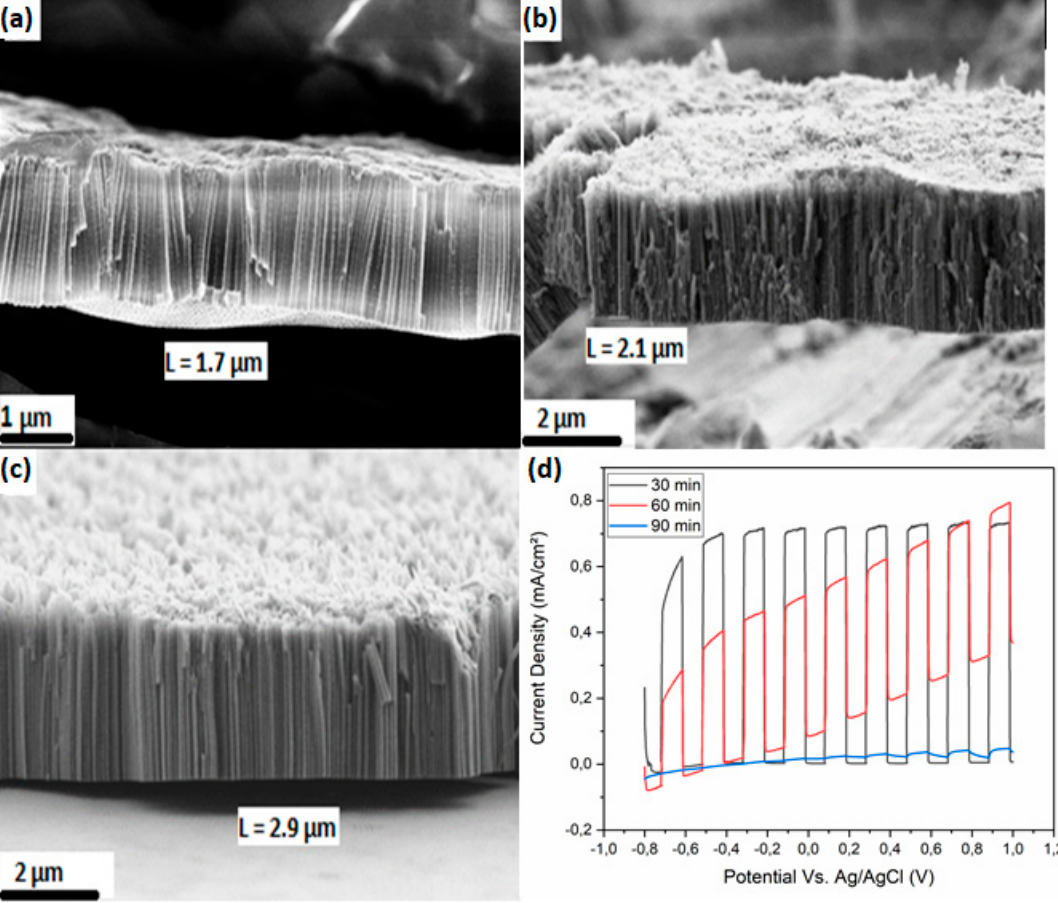
Figure 6. FESEM images of the TiO 2 nanotube arrays under different anodization times: ( a ) 30 min, ( b ) 60 min and ( c ) 90 min. ( d ) Corresponding photocurrent density under different anodization times (samples prepared using constant electrolyte concentration (0.8 wt% NH 4 F) and anodization voltage (30 V)).